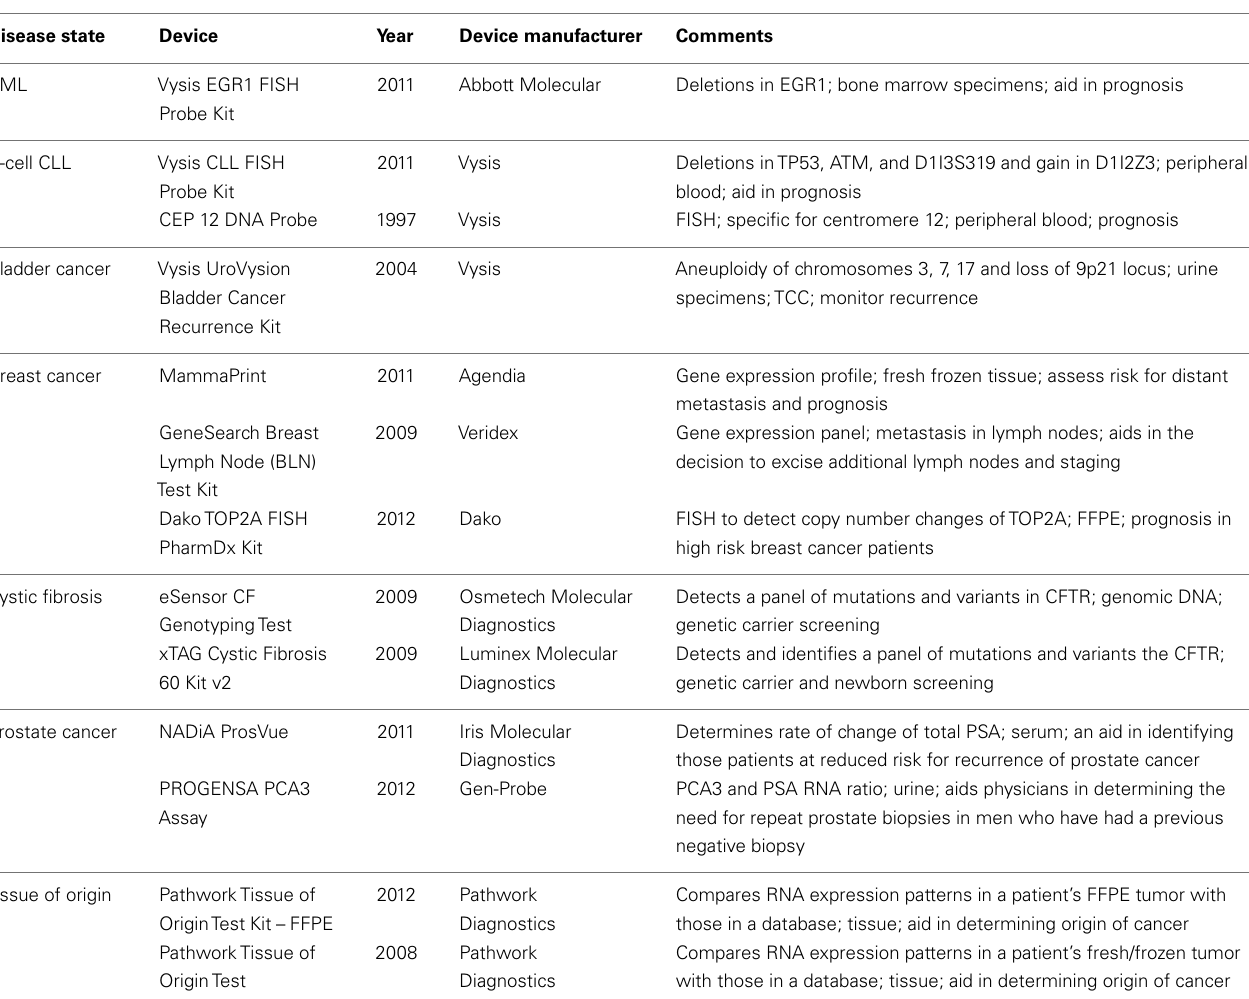
Table 3 | FDA 510(k) cleared molecular diagnostics (Dx)